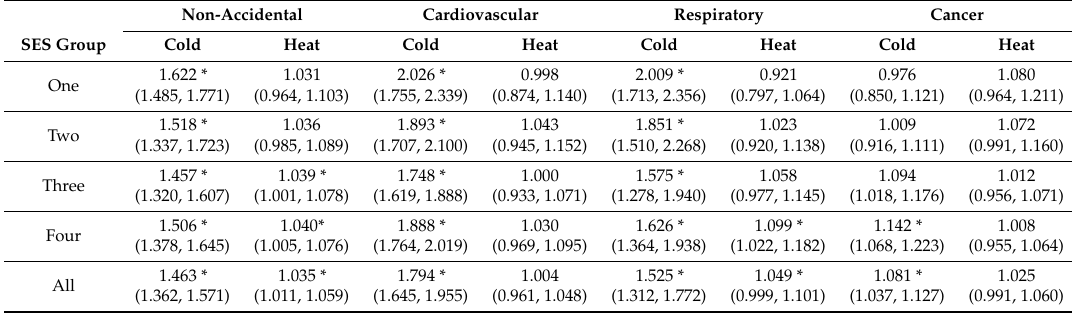
Table 3. The relative risk (RR) for cold (12.9 ◦ C, 2.5th percentile at lag 0–21) and heat e ff ect (30.3 ◦